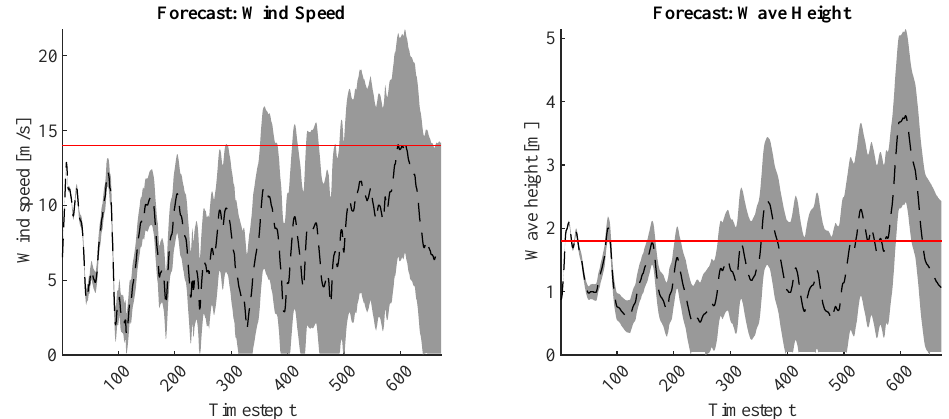
Figure 4. Simulated weather forecasts for three weeks starting on the 1st of June